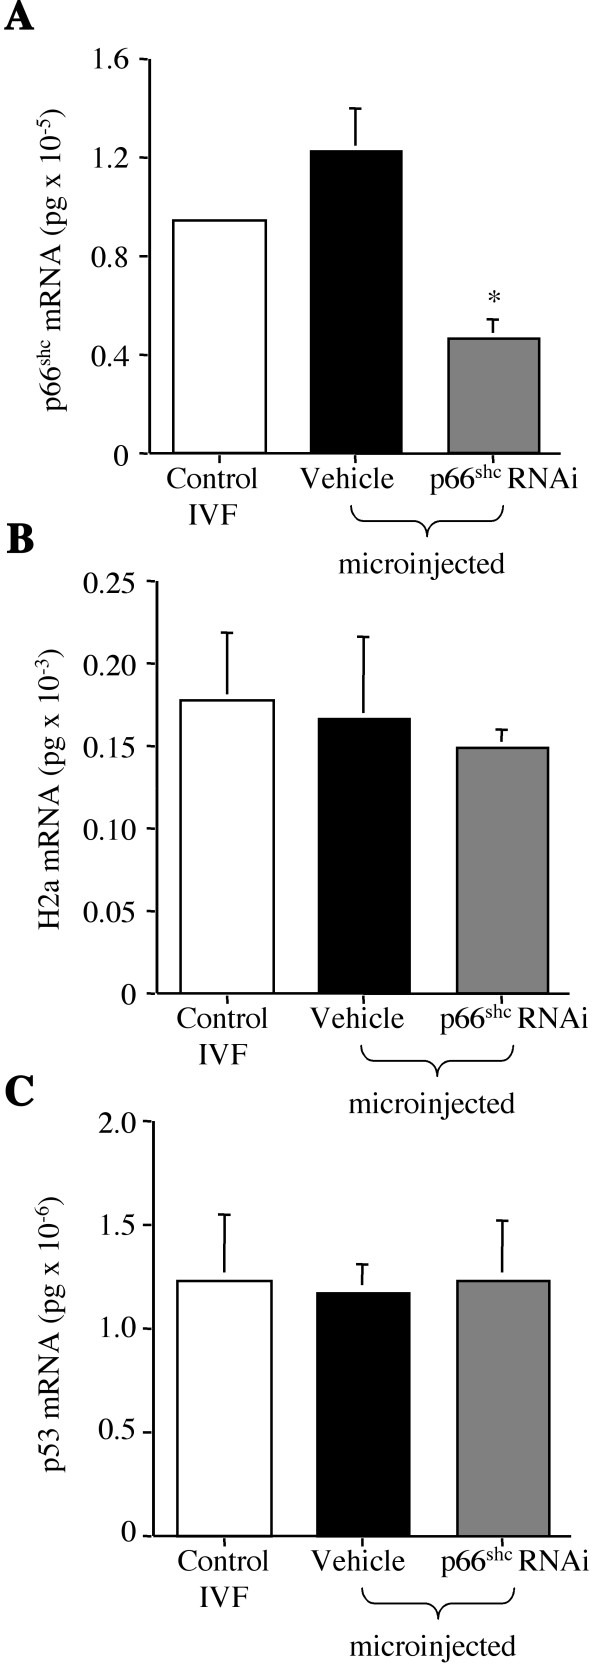
Real Time PCR quantification of p66Shc mRNA levels at the 2-cell stage following RNAi. Real Time PCR analysis of p66Shc (A) and H2a (B) mRNA levels in 35 hpi embryos following control IVF, microinjection of the vehicle and microinjection with 12,000 p66Shc hairpin RNAi molecules. p66Shc mRNA levels decreased in p66Shc RNAi microinjected embryos (*P < 0.001), while Histone H2a mRNA levels showed no significant differences (P = 0.744) among the three groups. This result provided evidence that the down-regulation of p66Shc mRNA levels following p66Shc hairpin RNAi molecule injection is selective for p66Shc transcripts. Real Time PCR analysis of p53 mRNA levels (C) for the three groups was also performed, showing no significant differences (P = 0.98). The experiments were conducted on three different pools of 80–100 embryos (n = 3) and replicated three times (r = 3) for each sample. The data were normalized for the content in one embryo.